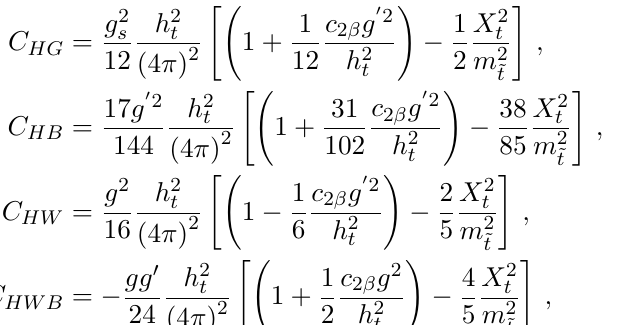
Figure 17 . Limits from the global fit in the stop parameter plane, ( X t correspond to the low and high tan β choices, 1 and 20